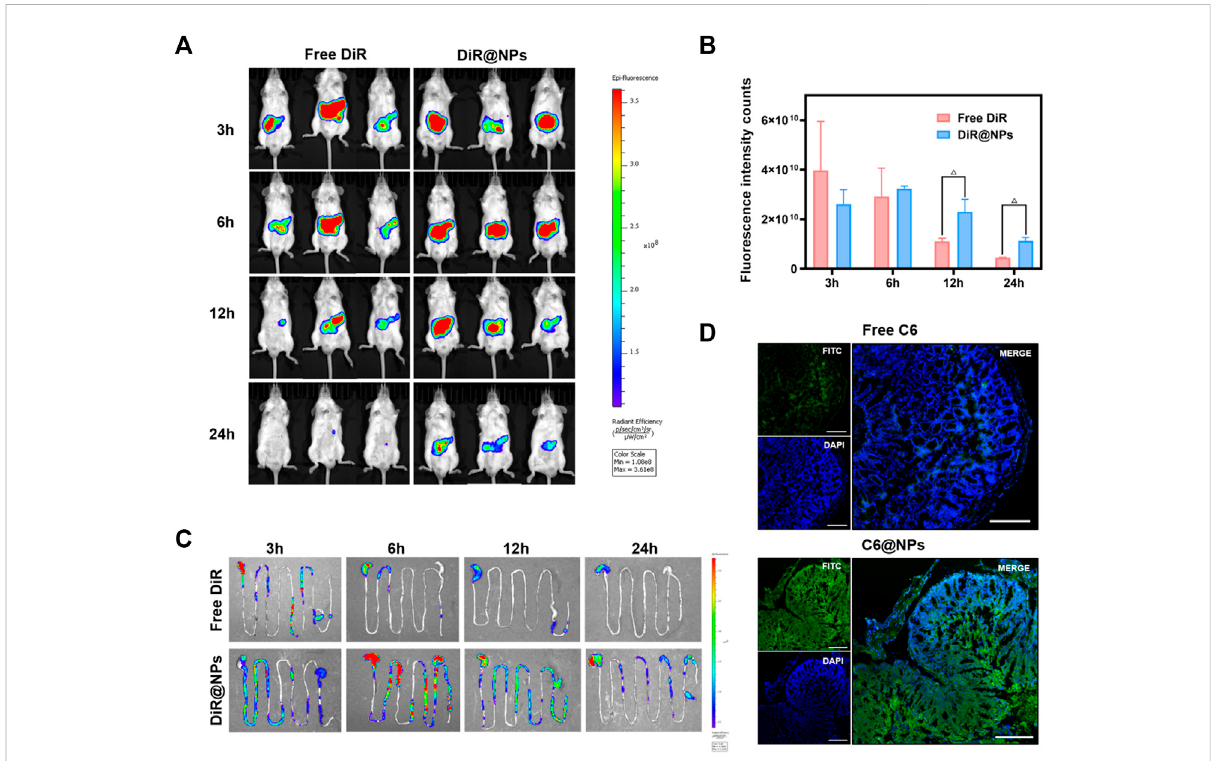
FIGURE 4 After the near-infrared fl uorescent dye DiR and C6 loaded into zein-Casein NPs, the advantages of zein-Casein NPs on colon-speci fi c accumulation and tissue penetration were observed. (A) Fluorescence images of mice at 3, 6, 12, and 24 h after oral administration of free DiR and DiR@NPs. (B) Histogram of fl uorescence intensity inmice at 3, 6, 12, and 24 hafter oral administration offree DiR and DiR@NPs (n =3, Δ p < 0.05). (C) Fluorescence images of the gastrointestinal tract of mice at 3, 6, 12, and 24 h after oral administration of free DiR and DiR@NPs. (D) Fluorescence images of frozen sections after oral administration of free C6 and C6@NPs for 12 h, green fl uorescence represented C6, and blue fl uorescence represented the location of the cell nucleus (scale bar = 200 μ